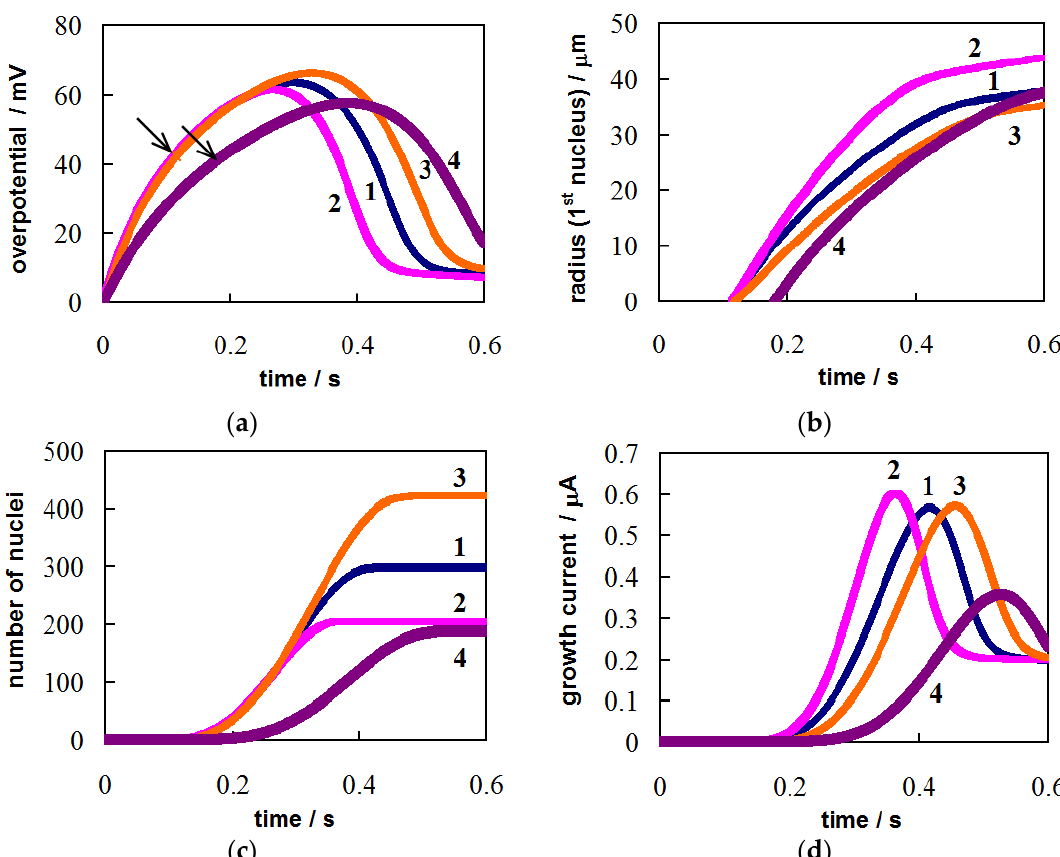
Figure 3. Calculated time dependences of ( a ) the overpotential, ( b ) the first nucleus radius, ( c ) the number of nuclei, and ( d ) the total growth current. Applied current density: i = 10 − 4 A с m − 2 (curves 1–3) and i = 6 × 10 − 5 A с m − 2 (curve 4). Values of c 0 and i 0 : c 0 = 1 × 10 19 cm − 3 , i 0 = 1 A cm − 2 (curve 1, blue); c 0 = 2 × 10 19 cm − 3 , i 0 = 1 A cm − 2 (curve 2, pink); c 0 = 1 × 10 19 cm − 3 , i 0 = 0.6 A cm − 2 (curve 3, orange). Other parameters are indicated in the text.